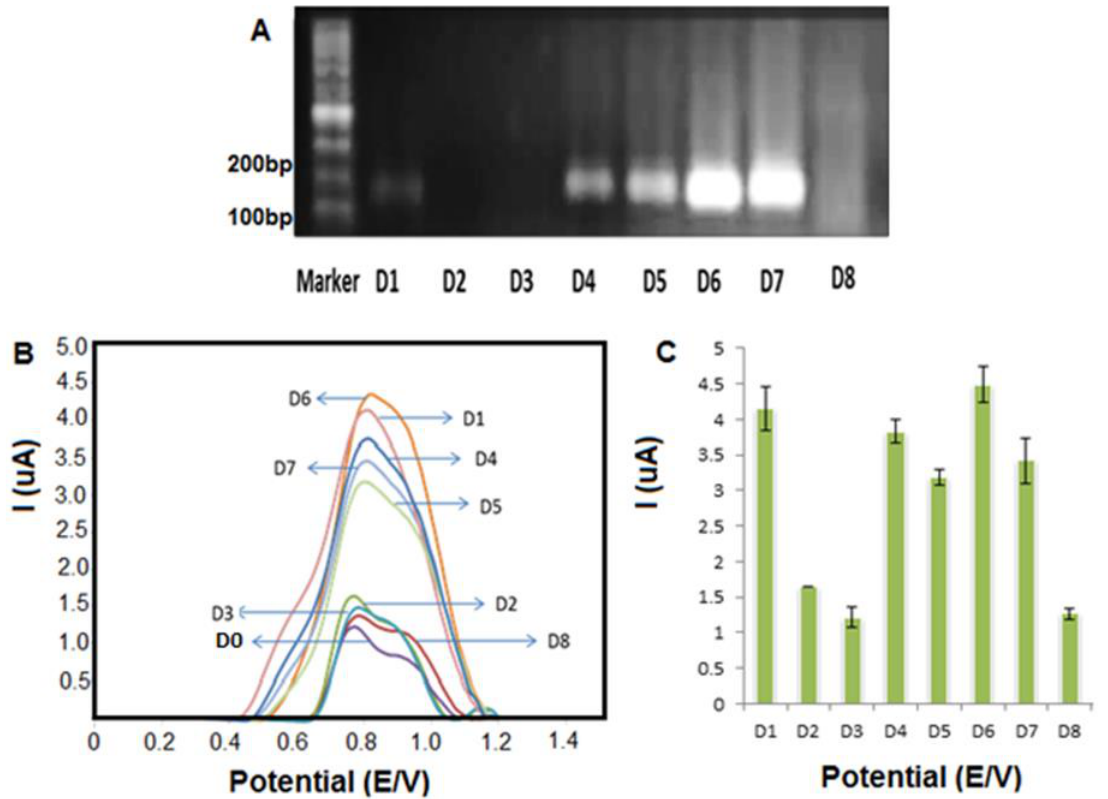
Figure 5. ( A ) Gel electrophoresis photographs of polymerase chain reaction (PCR) products obtained from D1 to D8; ( B ) DPV response for detection of D1 to D8 and; ( C ) DPV peak currents responding to the PCR products which was obtained from D1 to